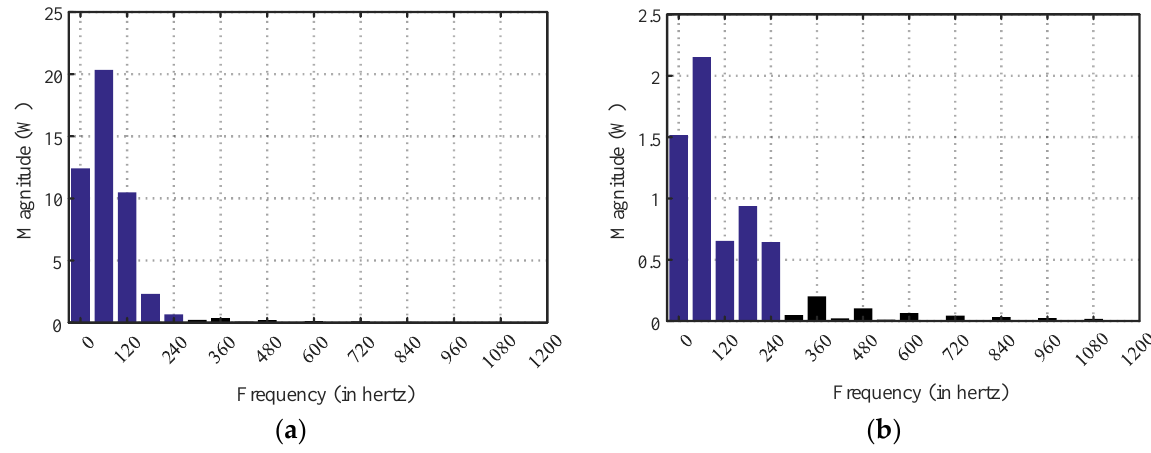
Figure 3. PV inverter ( a ) typical IGBT power-loss FFT and ( b ) typical diode power-loss FFT. As shown in Figure 3, the magnitudes of the harmonics at frequencies greater than 240 Hz are relatively small and can therefore be neglected. The recovered power loss waveform from the inverse Fourier transform of the selected harmonics is shown in Figure 4, which contains the waveforms recovered from (1) dc to the third harmonic, (2) dc to the fourth harmonic, and (3) dc to the fifth harmonic. The recovered time-domain waveform with the dc to the fourth-order harmonics has already achieved an acceptable accuracy. Hence, in this study, we select the spectrum from dc to the fourth harmonics (240 Hz for a 60 Hz system) as the heat source for the junction temperature.